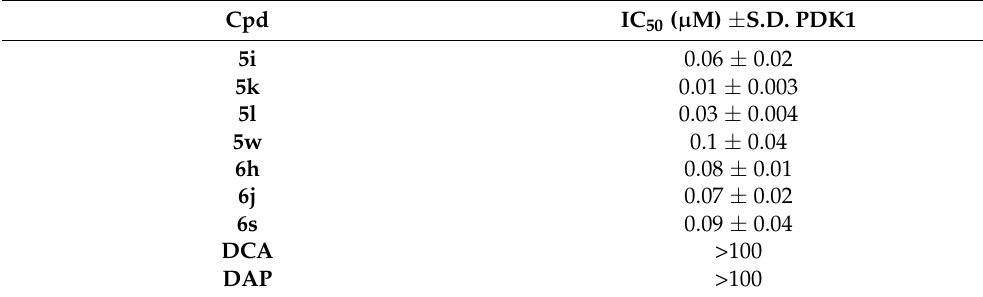
Figure 2. Inhibition of isolated enzyme isoforms. Heat-map showing the relative inhibition of tested compounds (at 1.5 µM) on PDK 1–4 ( A ) and HSP90 ( B ) enzymes. Results are expressed as enzyme residual activity. Data are the means of three independent experiments. Table 1. Inhibition of isolated PDK isoforms. IC 50 values were calculated by a four-parameter analyzed logistic model ( p < 0.05). DCA and DAP were reported as reference compounds. Data represent mean values from three independent experiments. S.D. = standard deviation.